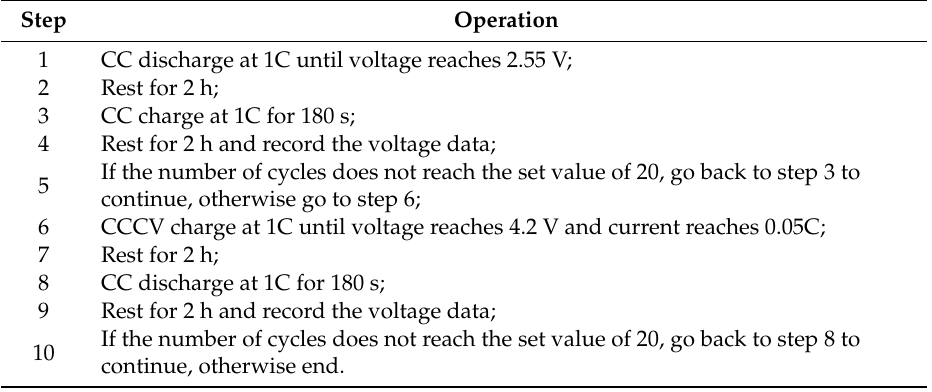
Table 2. Voltage relaxation test procedure under di ff erent